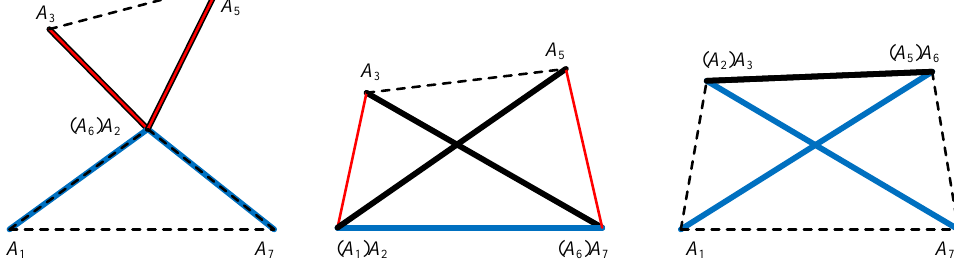
Figure 3. Typical singular